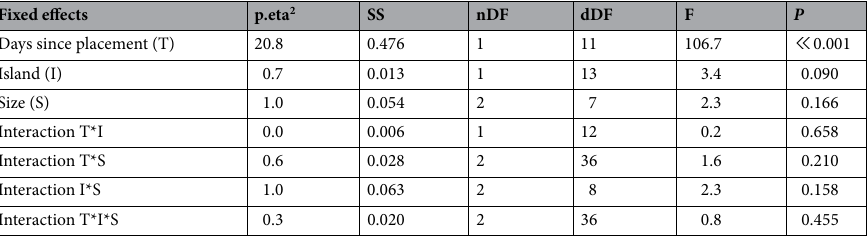
Table 3. Three-way random intercept and slopes mixed model analysis of the decomposition score of three body-size classes during the first 7 days after fresh carcasses were placed in the field in early spring on the islands of Lanzarote and Fuerteventura. For more details see Table 2.